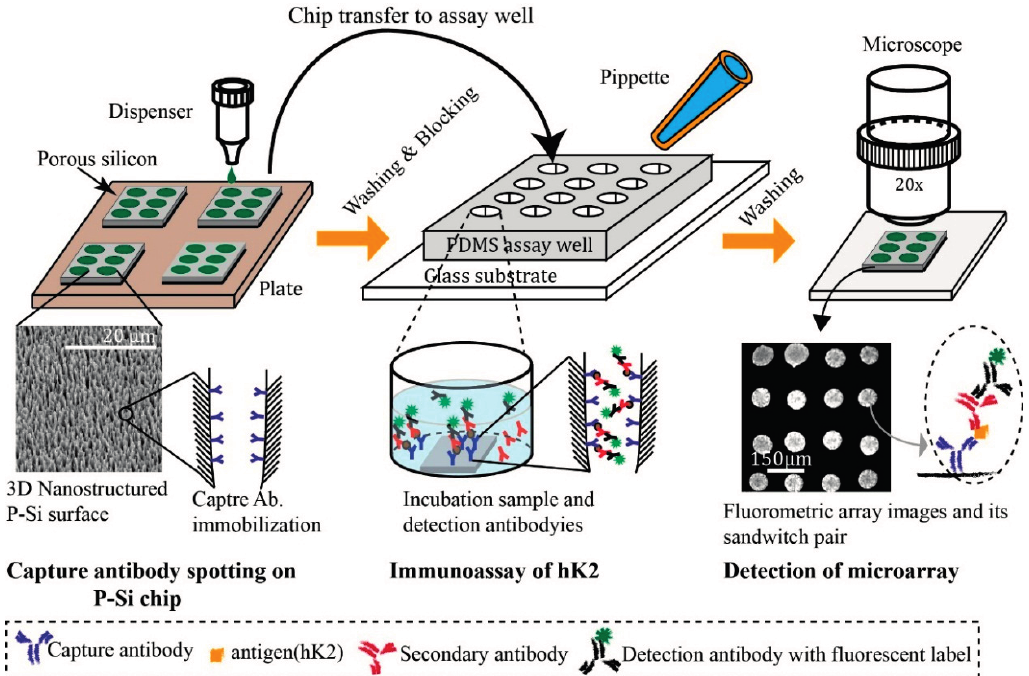
Figure 1. Schematic of the P-Si chip immunoassay procedure, starting with the